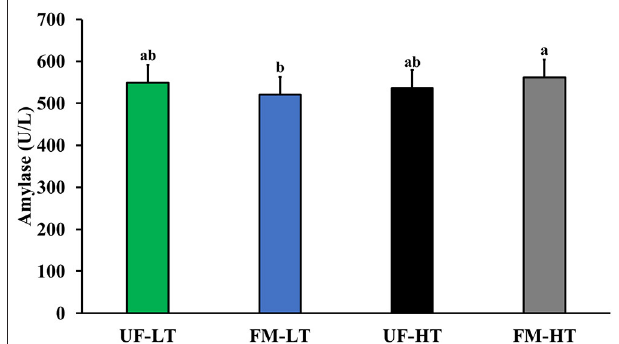
FIGURE 3 | Blood urea (A) and creatinine (B) content in dogs fed either normal (NP) or high protein (HP) commercial diets. Eight mixed-gender, neutered beagles were fed the NP, or HP diets during the first and sixth weeks, respectively * P < 0.10; ** P < 0.05. There was no effect of either fava bean (FB), fermentation (FM), or the interaction between FB and FM on urea and creatinine content ( P > 0.05). FB on digestibility of crude protein, gross energy, methionine, cysteine, or taurine ( P > 0.10).